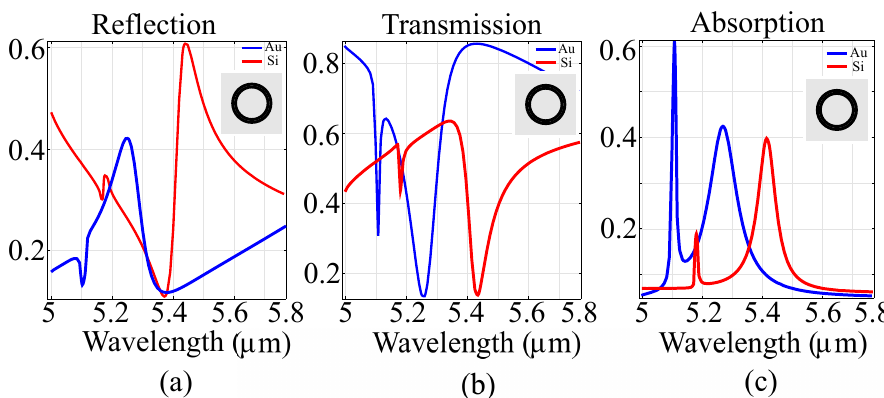
Figure 2. ( a ) Reflection , ( b ) transmission and ( c ) absorption of the ring architecture for a set of fixed parameters, using silicon and gold as materials. The inset presents the layout of the cell in the xy plane.